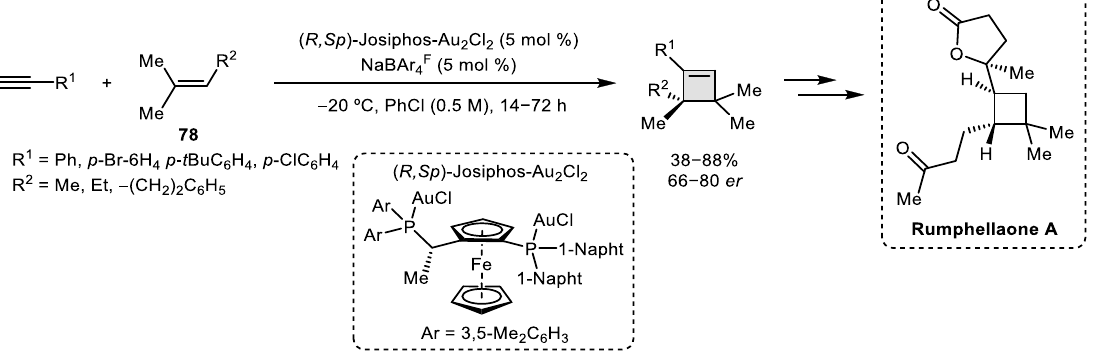
Scheme 26. Enantioselective [2 + 2] cycloaddition between terminal alkynes and trisubstituted